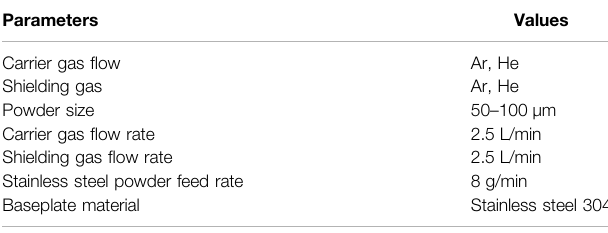
TABLE 1 | Stainless steel powder numerical simulation conditions.